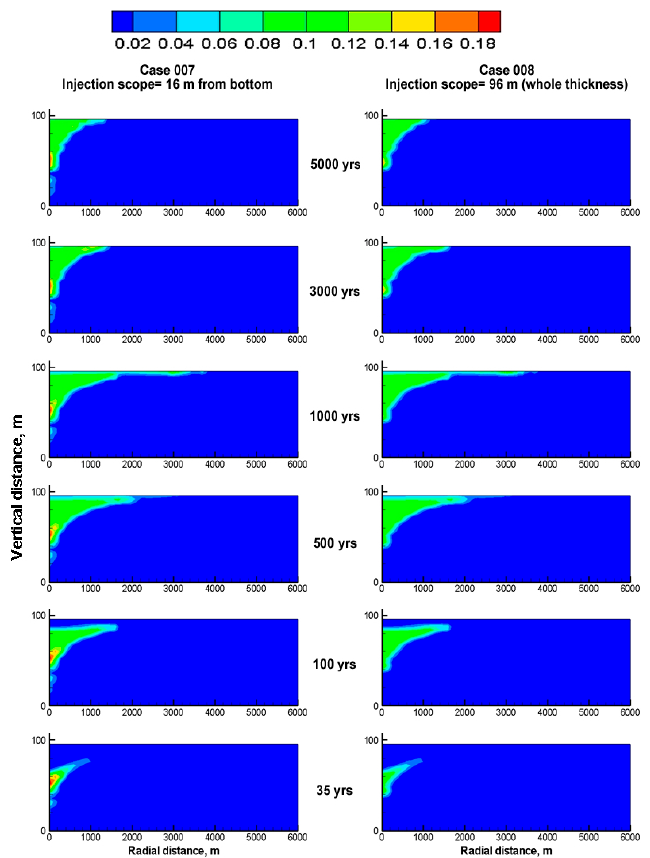
Figure 9. Impact of injection scope on trapped CO 2 mass distribution.